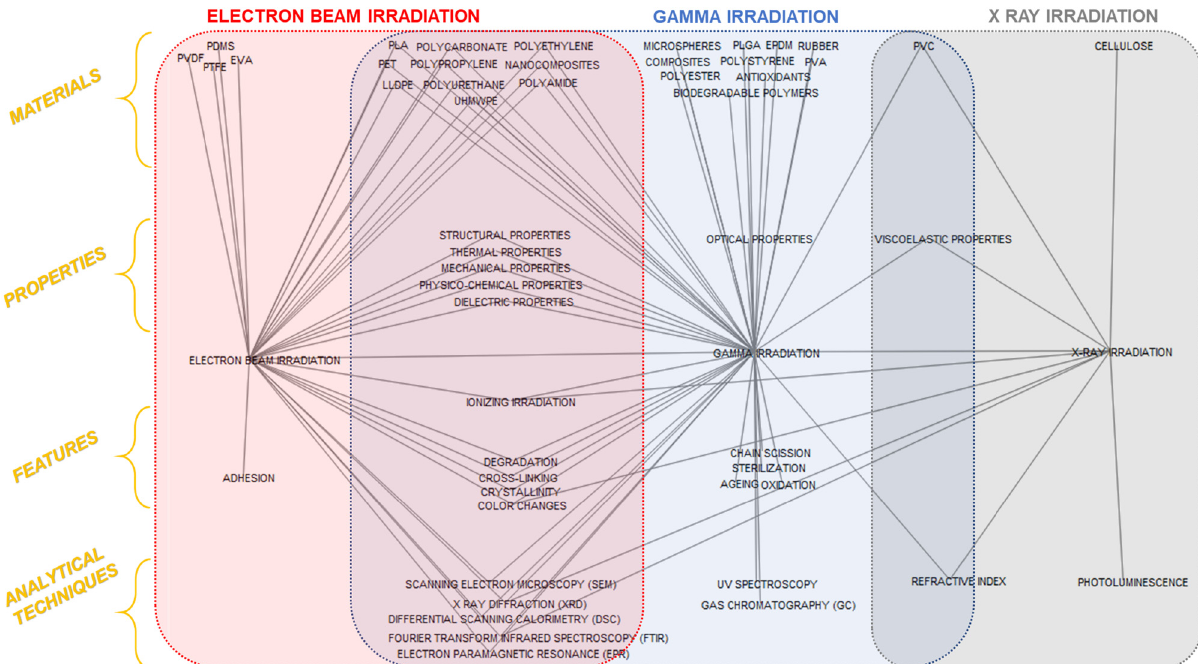
Figure 5: Keyword network ( 1975 – 2019 ) with a keyword ’ s frequency of minimum four for keywords linked with e - beam and gamma irradiation and two for those linked with X - ray